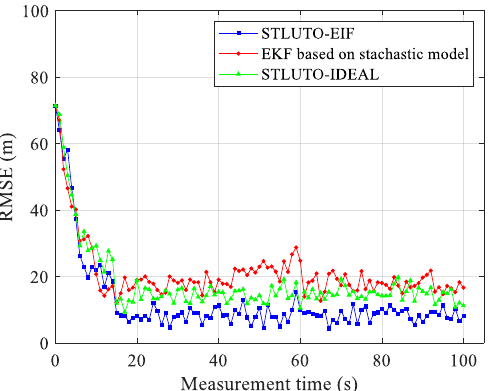
Figure 8. RMSE errors of target localization for the moving target with constant turn rate.